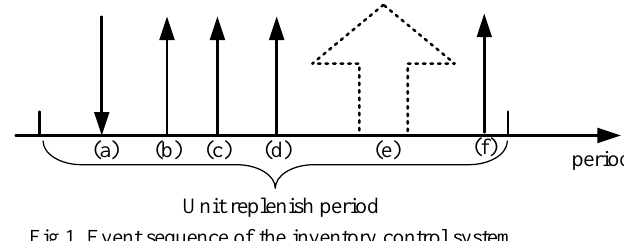
Fig.1. Event sequence of the inventory control